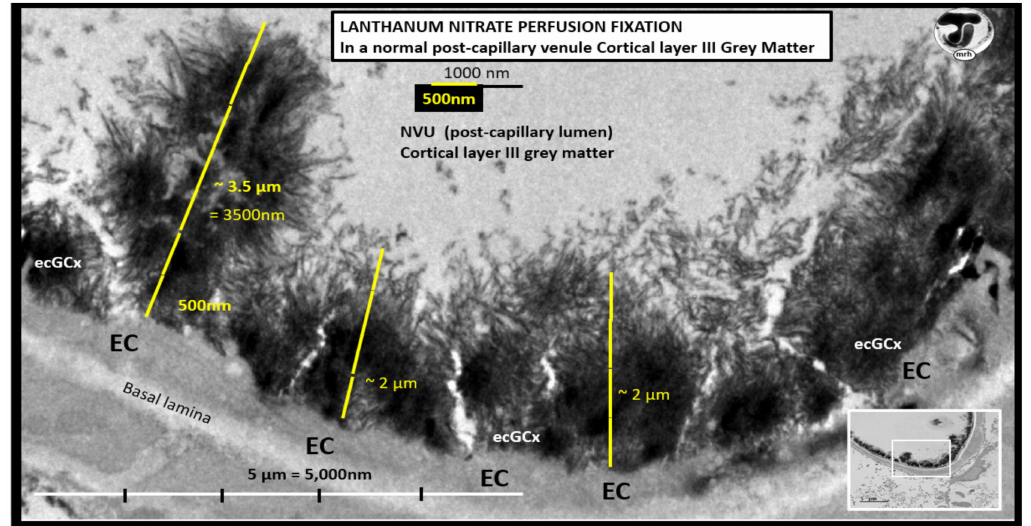
Figure 15. Exploded transmission electron microscope (TEM) image of a perfusion fixed control. lanthanum nitrate-stained post-capillary venule in cortical layer III of the frontal grey matter regions in a CD1 mouse model at seven-weeks of age. Note the marked electron-dense endothelial glycocalyx (ecGCx) on the luminal-apical brain endothelial cell (BEC). In this healthy control model, the ecGCx varies from ~2 to 3.5 µ m in thickness. Note how the apical fronds of the ecGCx can readily interact with proteins of the circulating plasma. This staining technique has now been found to be both reliable and reproducible by author and others [52,57,58]. Note the original image in the lower-right insert with scale bar = 5 µ m. Scale bar = 500 nm utilized to measure the ecGCx thickness in the exploded